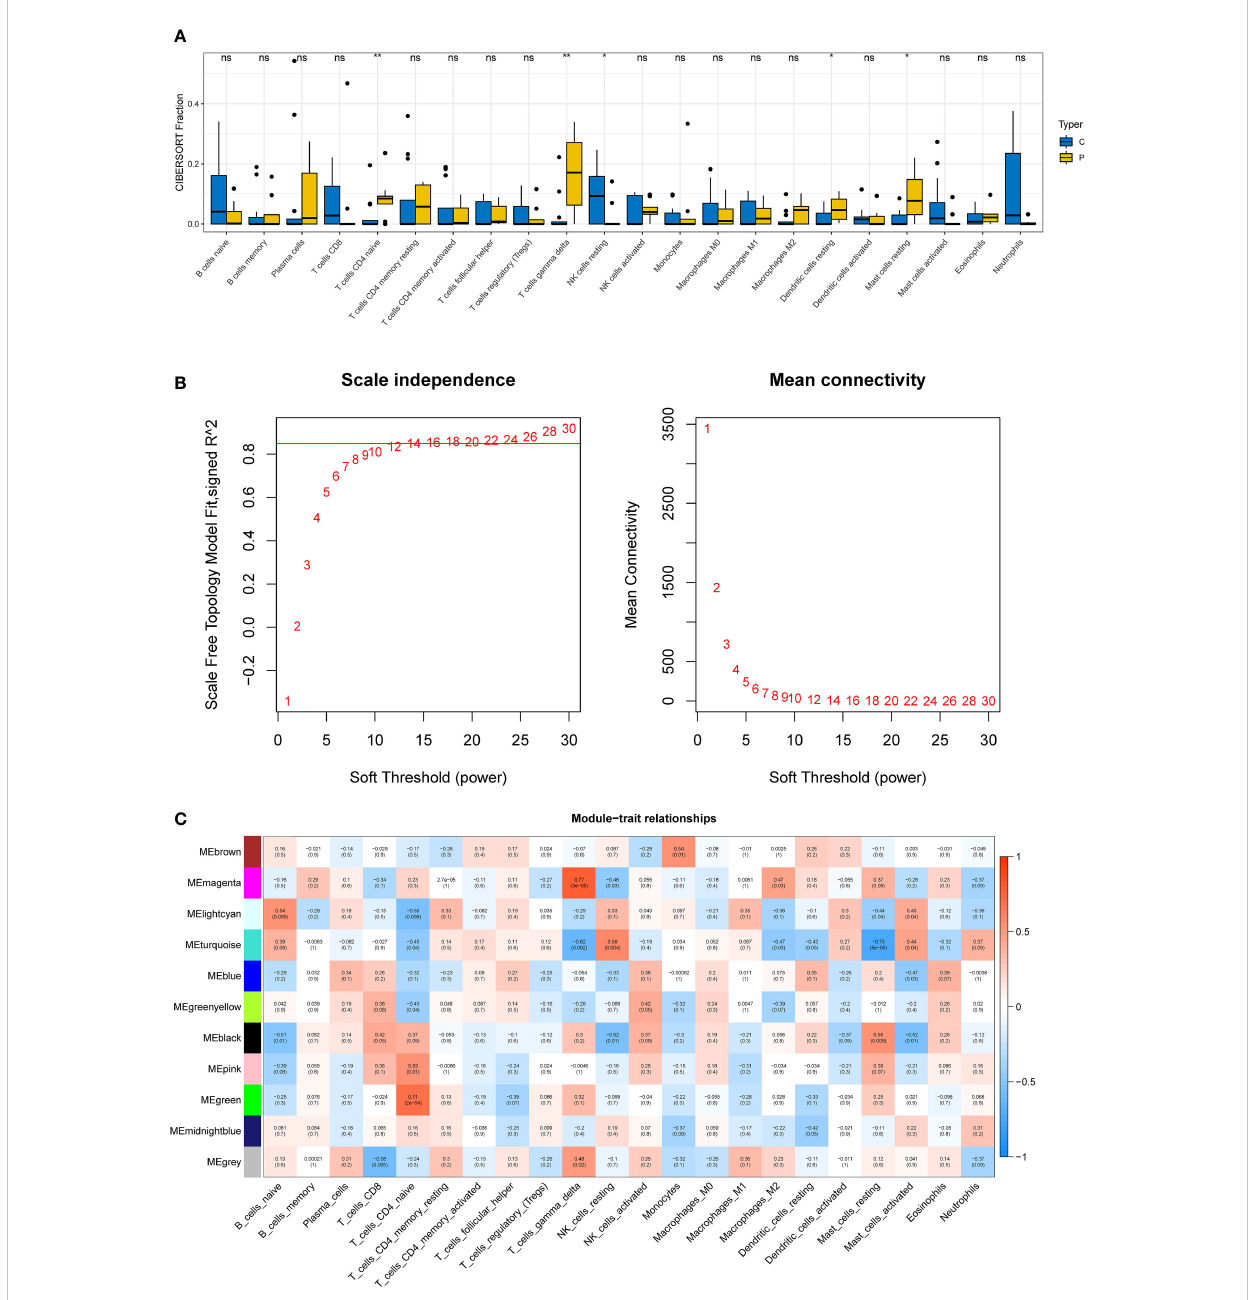
FIGURE 3 Immune in fi ltration analysis and construction of weighted gene co-expression networks. (A) 22 immune cells in samples with normal and diabetic nephropathy in GSE30528. (B) Choosing the best soft-threshold power. (C) 11 modules revealed by the WGCNA. WGCNA, weighted gene co-expression network